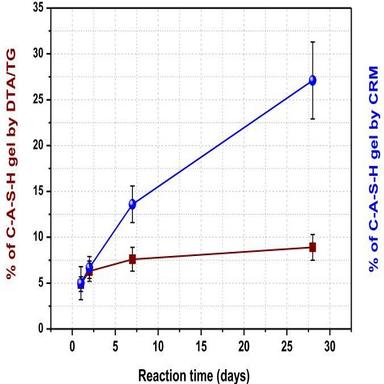
Semi-quantitative determination of the presence of C-A-S-H gel determined by Confocal Raman Microscopy (% by volume) and by DTA/TG (% by weight).